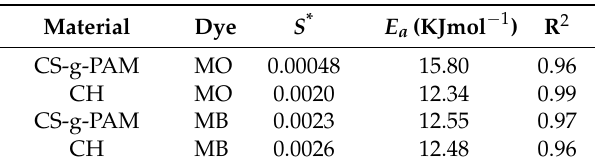
Table 4. The values of S * and Ea for the decolorization of MB and MO by chitin and chitosan-g-PAM (pH 8.0 for MB and 5.0 for MO; initial MB/MO concentration: 4.0 mg/L; mass of CH and CS-g-PAM: 0.3 g · 100 mL − 1 ).